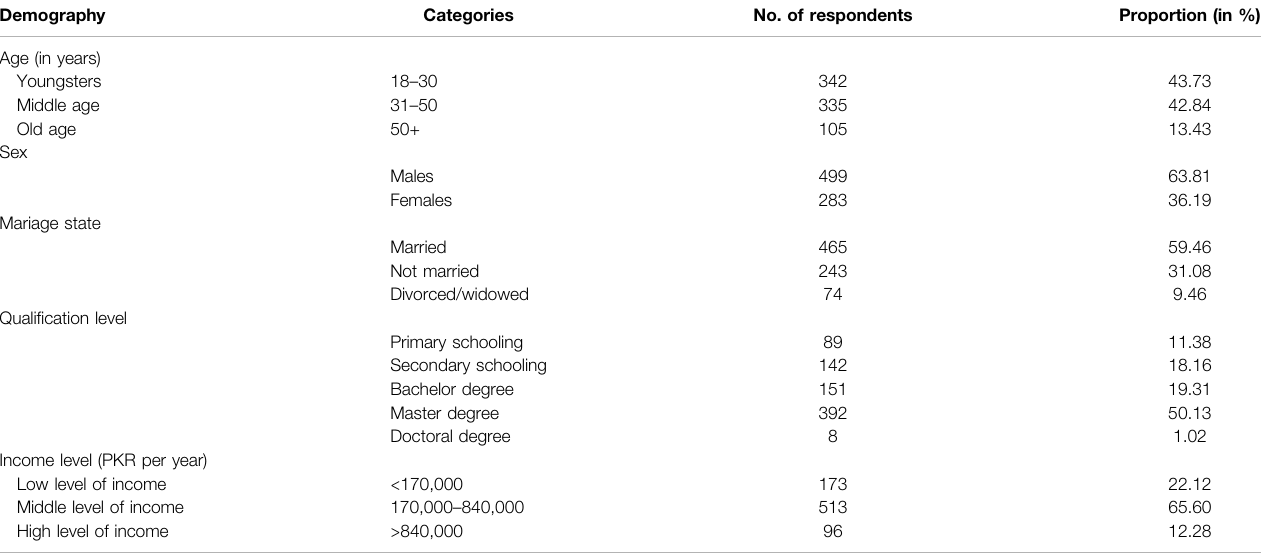
TABLE 1 | Demographic attributes of respondents.